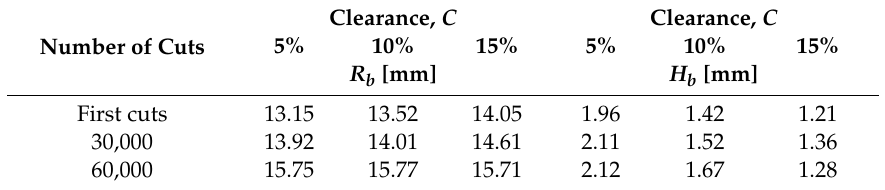
Figure 12. Effect of clearance on the size of the burr (after the first cuts with a punch).